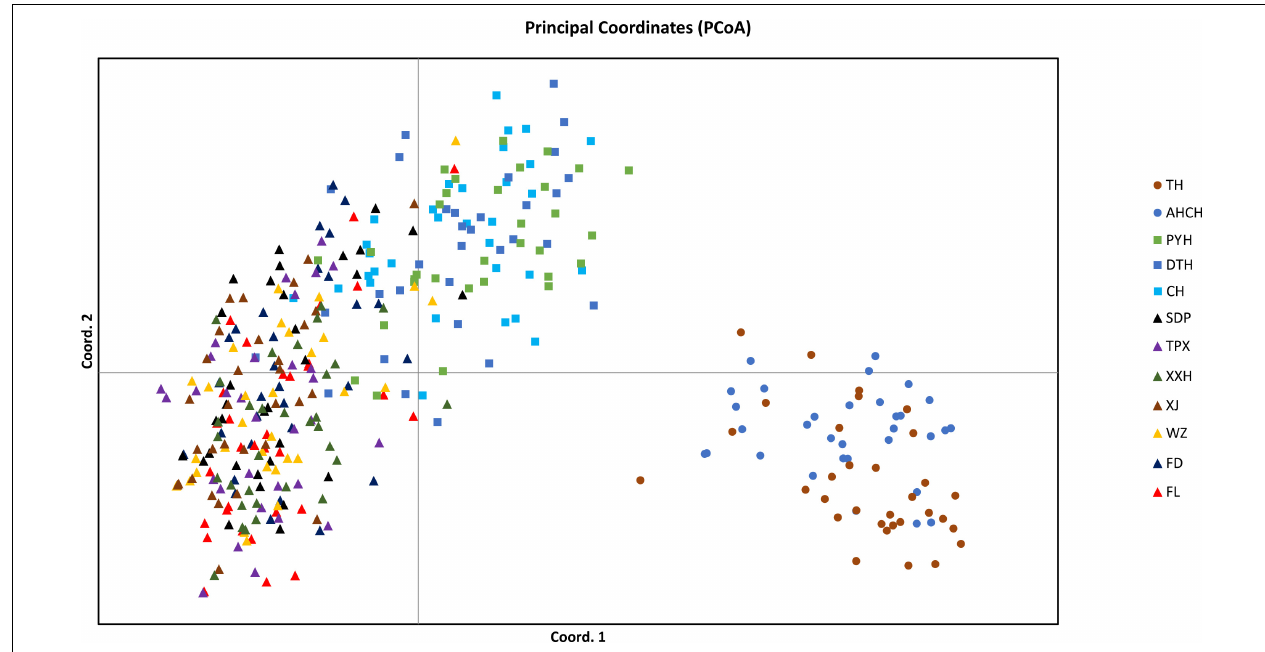
FIGURE 5 | The PCA showing the relationship of the PC1 and PC2 components of 12 C. brachygnathus populations in the Yangtze River Basin. Each triangle (square or circle) represents one sample corresponding to a specific population. The triangles represent the samples from the Three Gorges Reservoir; the squares represent the samples from the middle Yangtze River, and the circles represent the samples from the lower Yangtze